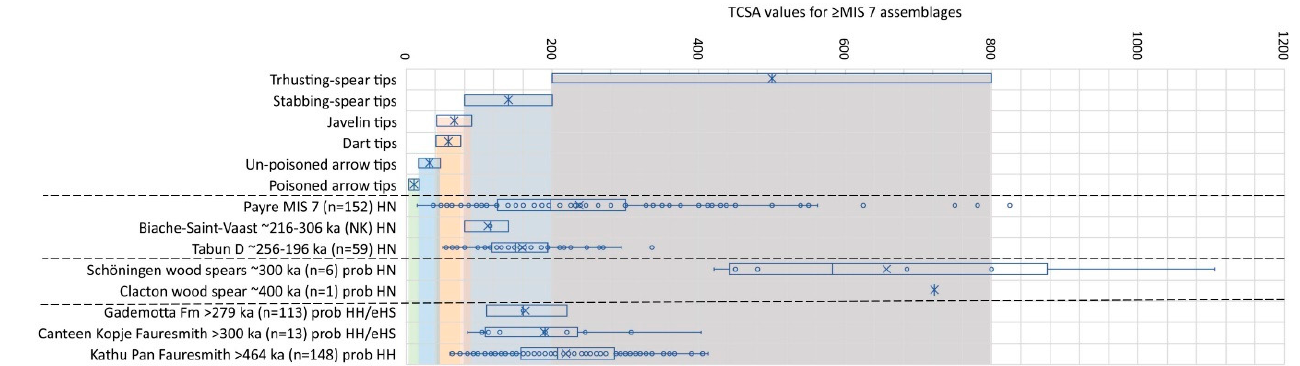
Figure 2. Comparative analysis of TCSA values for assemblages dating to MIS 7 and older. Key to assemblages: HN = assemblages with Homo neanderthalensis fossil material; prob HN = assemblages with no known hominin fossil material, but probably produced by H. neanderthalensis ; prob HH = assemblages with no known hominin fossil material, but probably produced by H. Heidelbergensis ; eHS = early/archaic H. sapiens . Key to boxplot information: lines in boxes = median TCSA values, x in boxes = mean TCSA values, circles in/outside boxes = TCSA values for each tool measured, the dashed black lines sub-divide assemblages for easier reading. Data sources: Biache-Saint-Vaast [72]; Tabun [40,41]; Schöningen and Clacton [41]; Gademotta [75]; Kathu Pan [36].